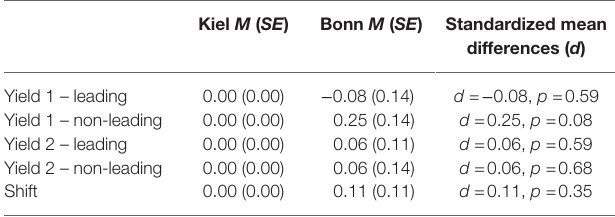
TABLE 10 | Latent means of Research institution (Kiel compared to Bonn) for the latent GSS 1 factors and the standardized mean difference d .